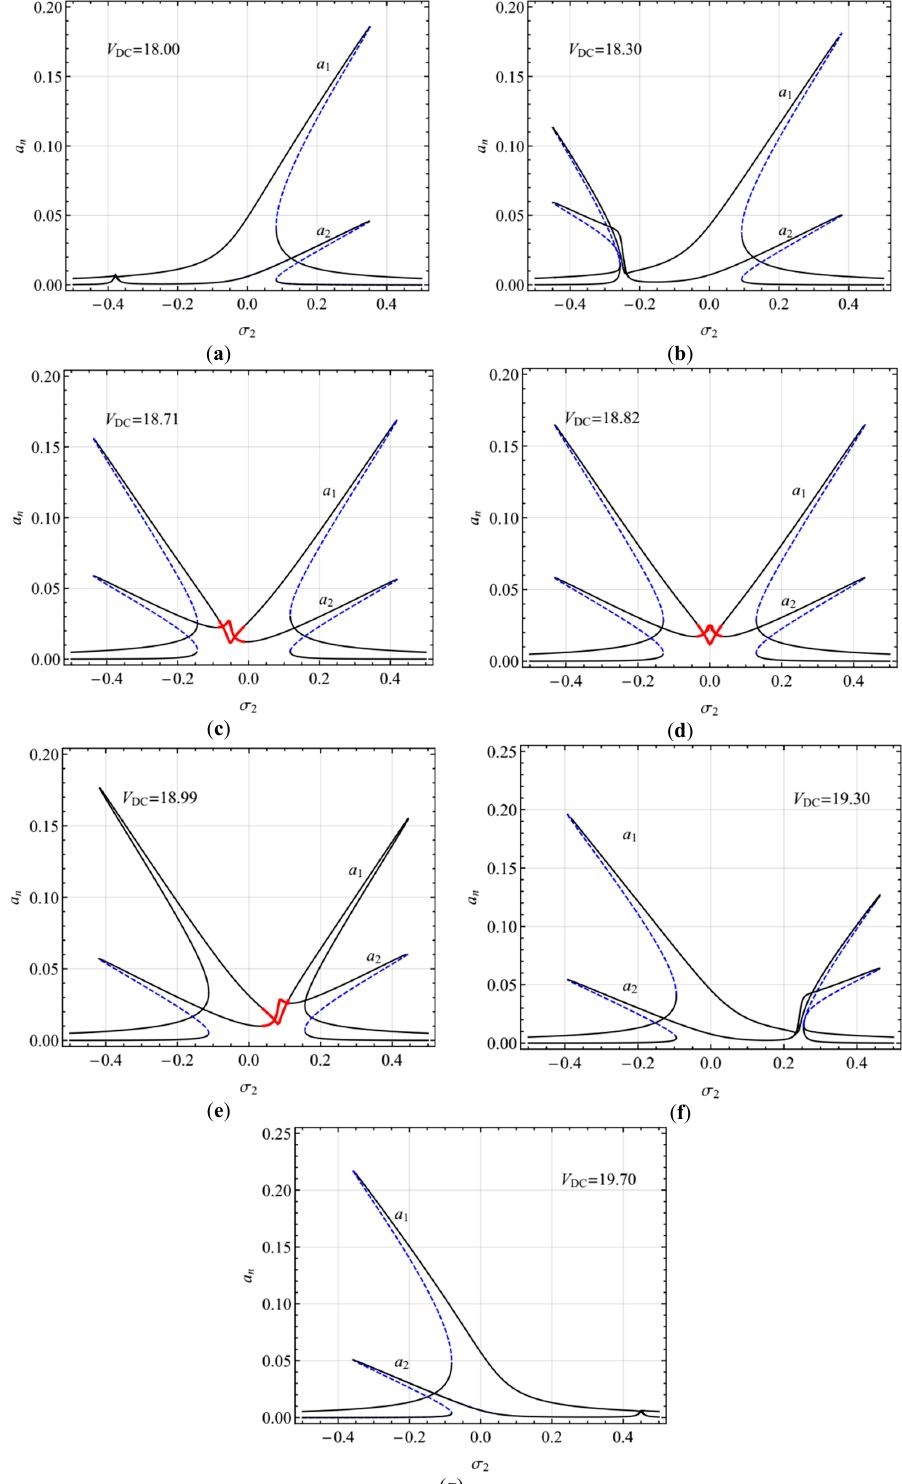
Figure 5. Frequency-response curves of primary resonance of the first mode for different DC voltage ( a ) V DC = 18.00 ( σ 1 = -0.75), ( b ) V DC = 18.30 ( σ 1 = -0.49), ( c ) V DC = 18.71 ( σ 1 = -0.10), ( d ) V DC = 18.82 ( σ 1 ≈ 0), ( e ) V DC = 18.99 ( σ 1 = 0.17), ( f ) V DC = 19.30 ( σ 1 = 0.48), ( g ) V DC = 19.70 ( σ 1 = 0.90).